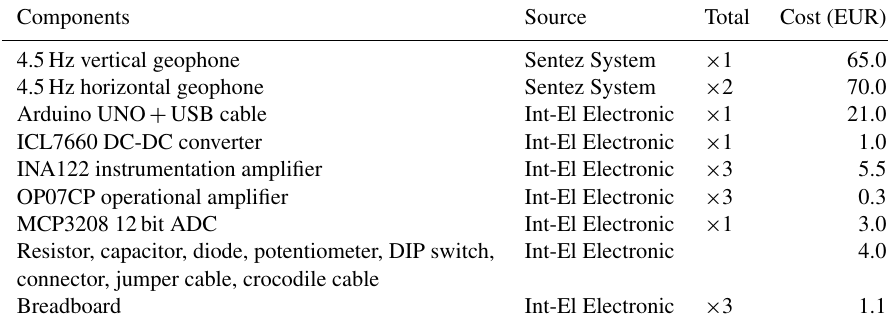
Table 1. List of the electronic